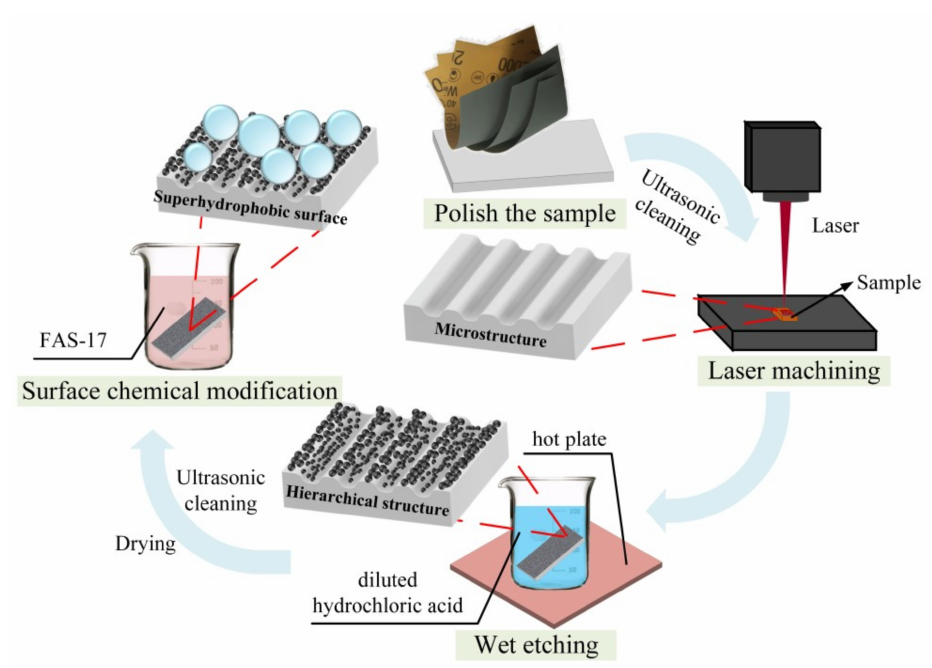
Figure 2. The overall preparation process of the hierarchical